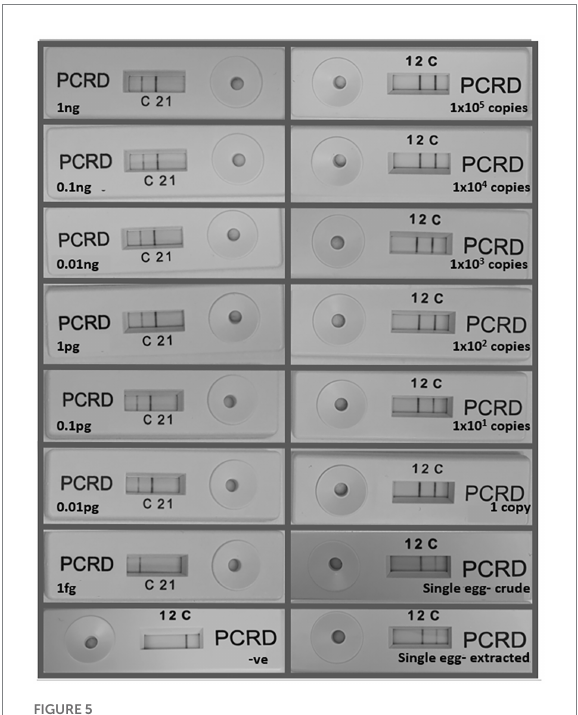
FIGURE 5 Limit of detection of the SmMIT-LF-RPA. The assay was able to detect down to 10 fg of the gDNA, one copy of the synthetic target DNA, and one single egg with or without DNA extraction. Legend: ng, nanogram; pg, picogram, fg, femtogram; +ve, positive control (1 ng of Schistosoma mansoni gDNA); and − ve, negative control